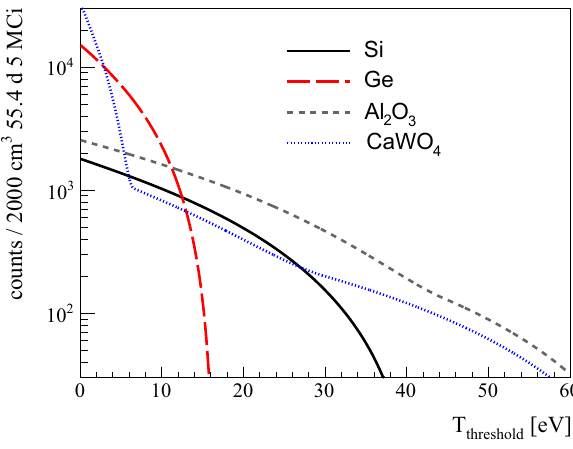
Fig. 4 Counts above threshold for different types of 2000 cm 3 detec- tors from 55.4 days of exposure to a source of 5 MCi initial activity, in the same experimental configuration of Fig. 3 smaller than the signal if the experiment is located at a dis- tance greater than 25